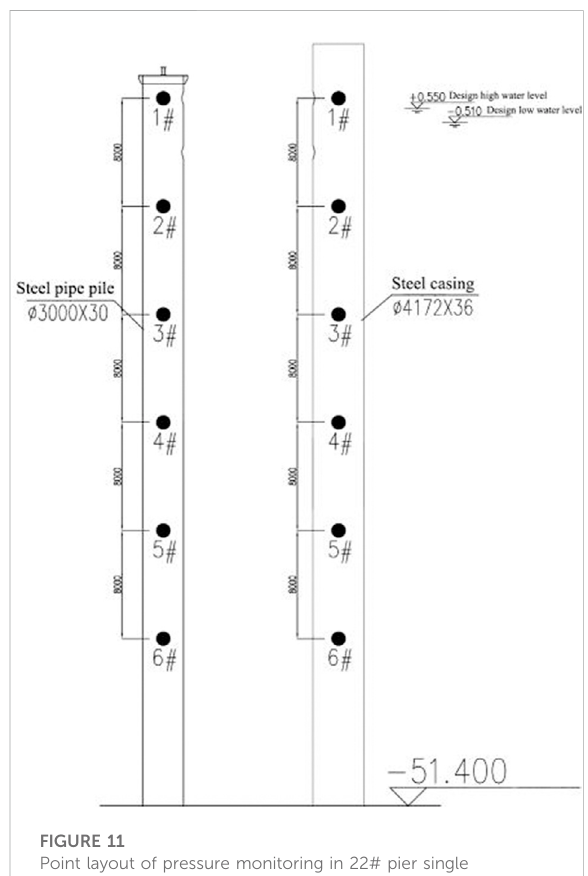
FIGURE 11 Point layout of pressure monitoring in 22# pier single platform pile and steel